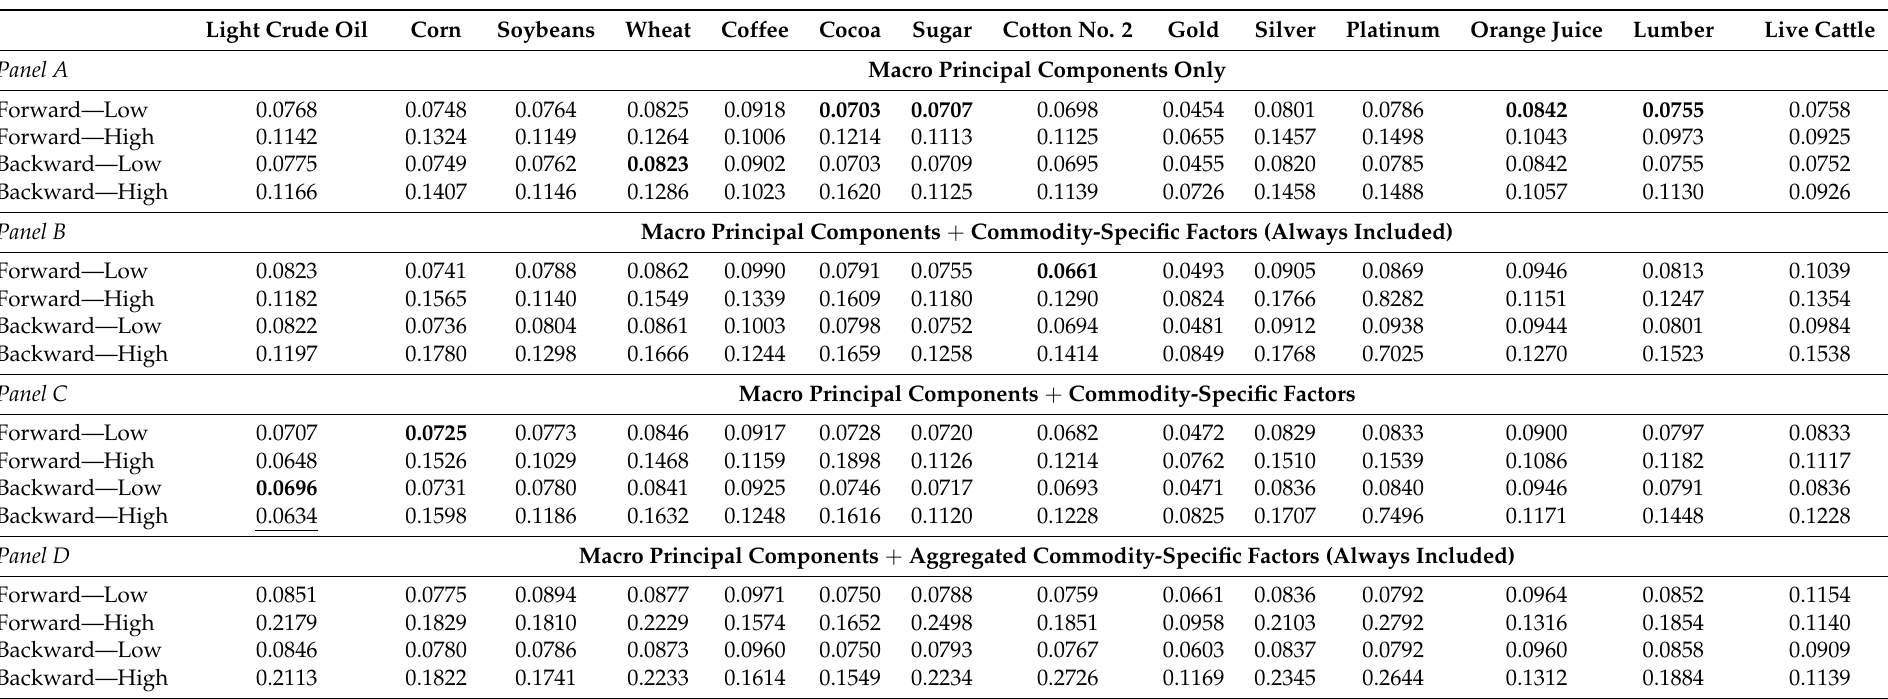
Table 1. The tables reports mean square error forecast performances—classification by low- vs. high-risk aversion samples. The table reports the RMSFE implied by the forecasts obtained from the 12 stepwise (forward vs. backward) predictive regression models recursively implemented in our analysis. In particular, the table distinguishes between the RMSFEs obtained in periods of low vs. high market volatility (a proxy for aggregate risk aversion). Specifically, the periods of low